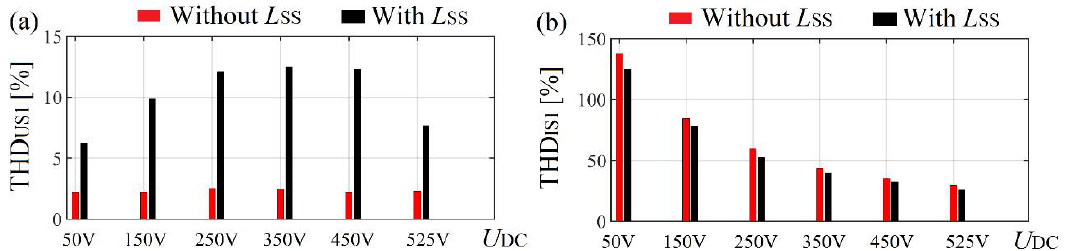
Figure 41. Comparison before and after the line reactor connection of the PCC voltage THD ( a ) and grid current THD ( b ).